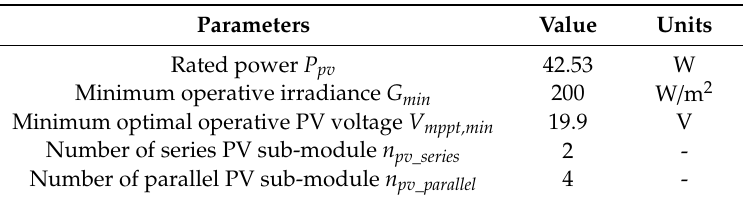
Table 2. PV module parameters.